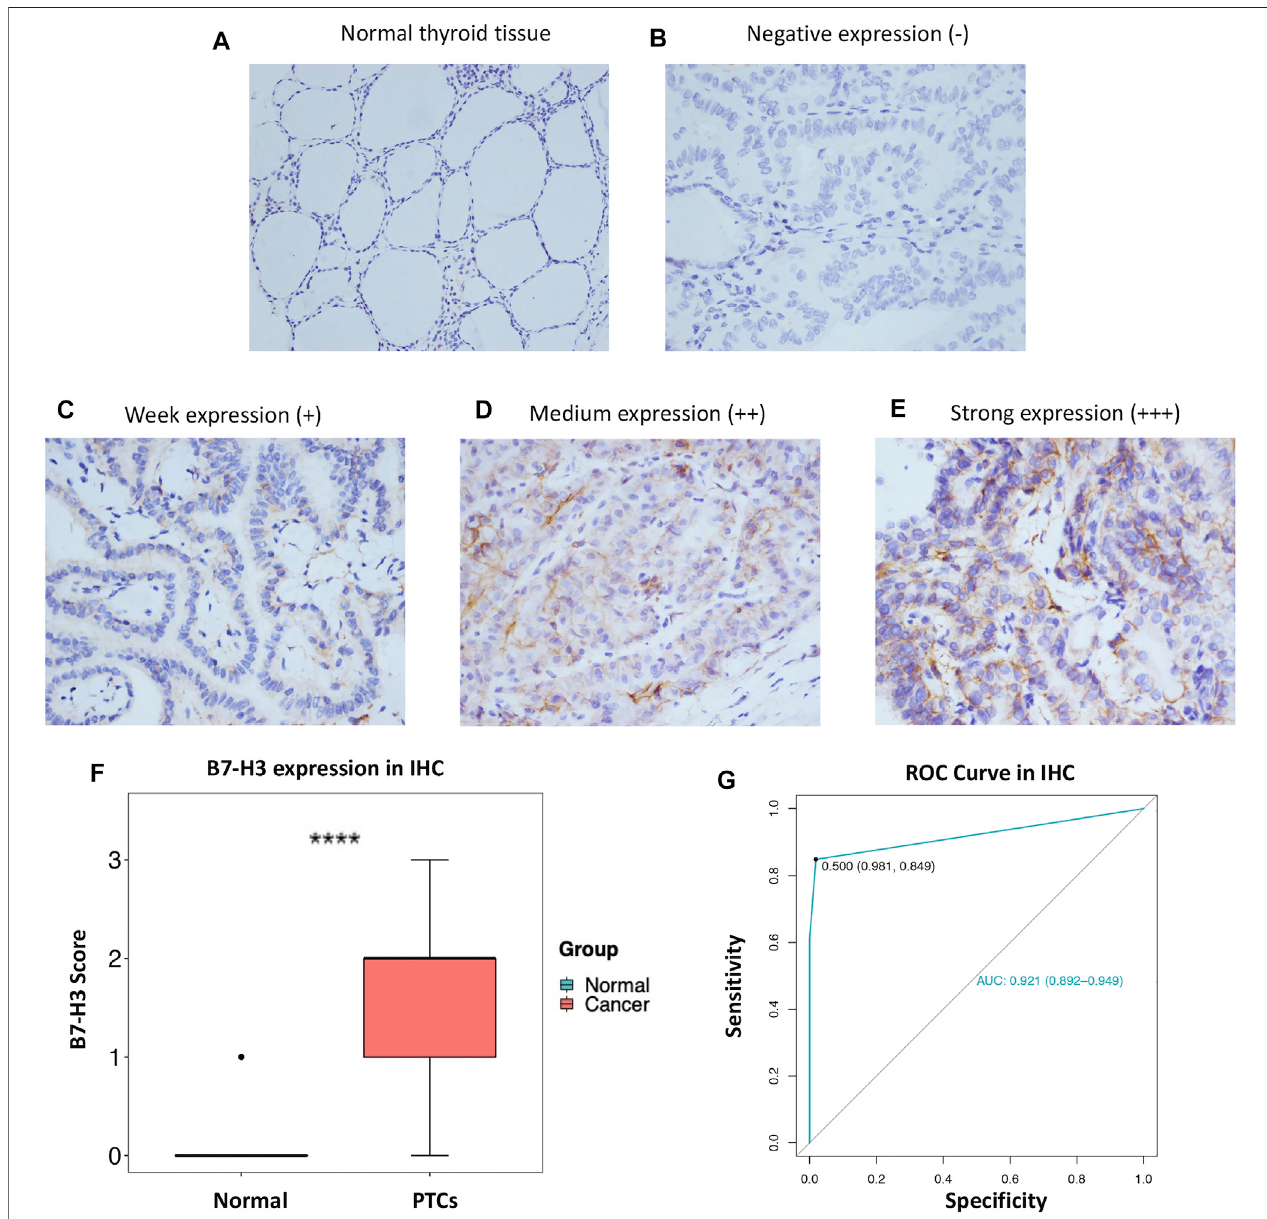
FIGURE2| Proteinexpressionpro fi leofB7-H3inPTC(200×)andnormalthyroidtissue(100×) (A – E) .B7-H3expressionscoreinPTCandnormaltissue (F) .ROC curve of B7-H3 protein expression in PTC (G) . **** represents p < 0.0001.